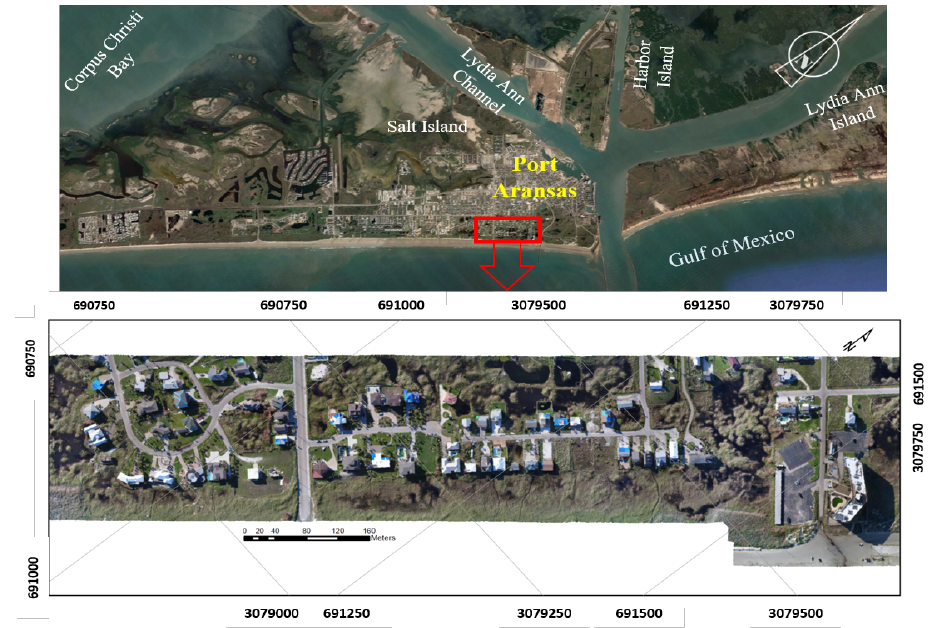
Figure 7. Port Aransas study site located along the southern Texas Gulf of Mexico coastline. The square box (top figure) shows the UAS flight area, which has been illustrated with more details in the UAS-derived ortho-image (bottom